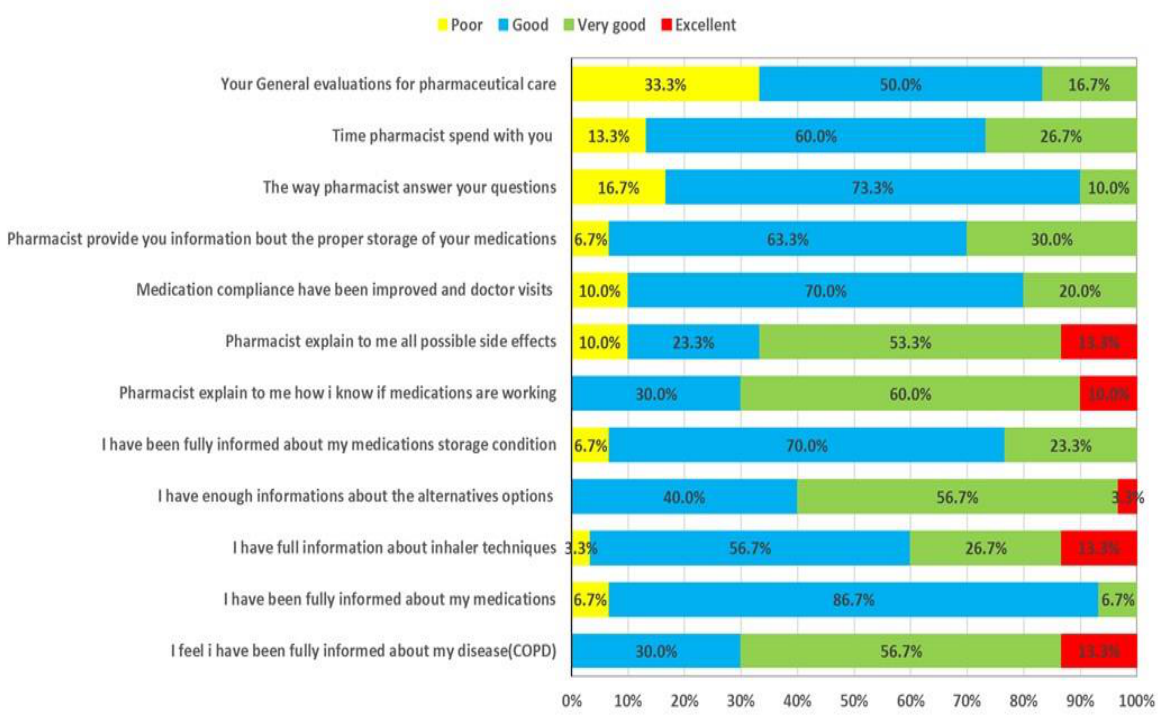
Fig. 1. Percentages of patients in the categories of responses to the patient satisfaction survey for the provided pharmaceutical care